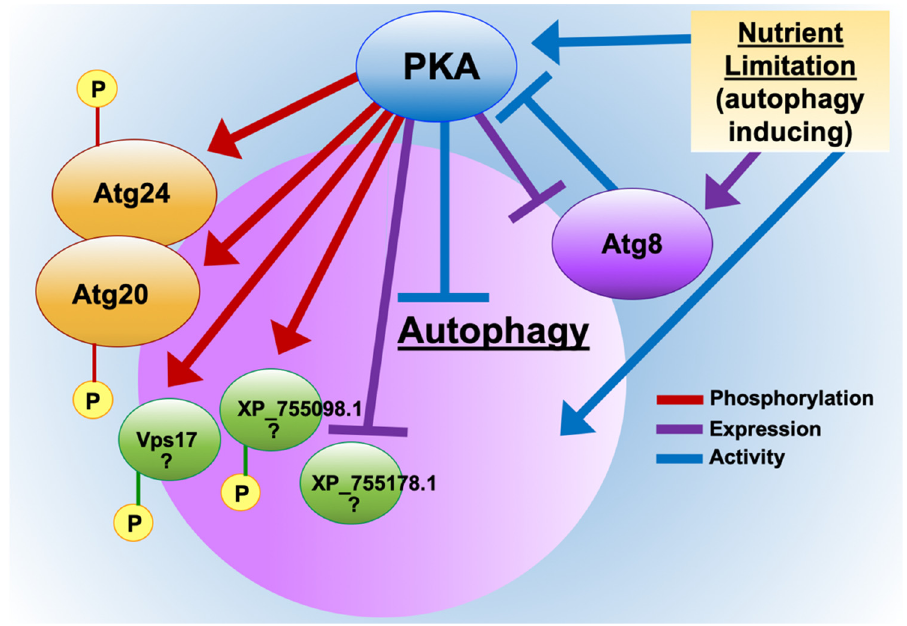
Figure 6. Schematic model showing PKA regulation of autophagy in A. fumigatus . Identified autophagy-associated proteins, processes, and conditions regulating and regulated by PKA with regard to phosphorylation, protein expression, and activity, as indicated. “P” indicates phosphorylation of the effector proteins by PKA. Arrows represent positive regulation, whereas bars represent negative regulation. Question marks indicate putative nature of additional proteins’ involvement in autophagy. Regulation of phosphorylation, expression, or activity may be direct or indirect in each case depicted.